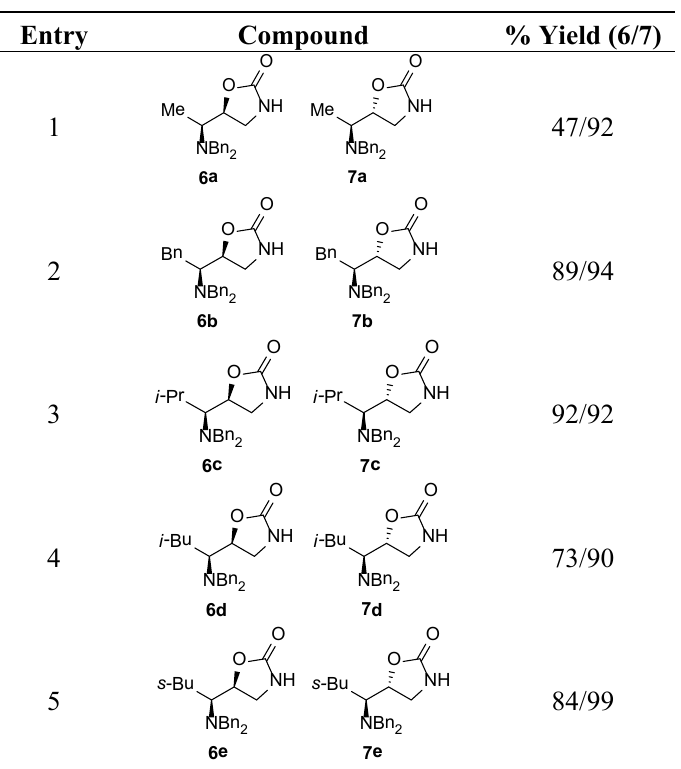
Table 1. Synthesis of 1,3-oxazolidin-2-ones 6 and 7